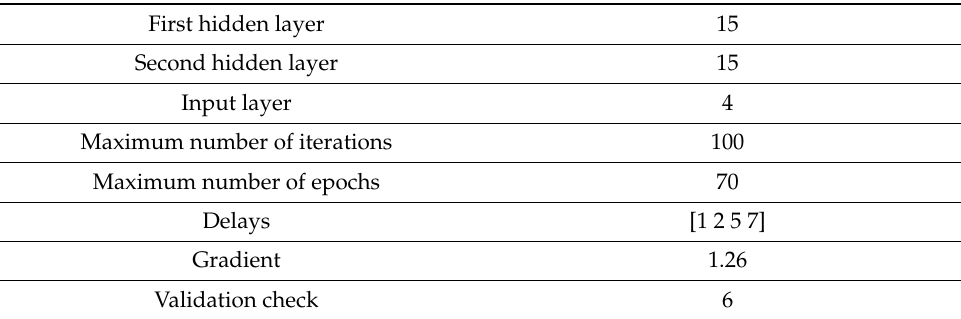
Table 1. Parameters of the developed MLP